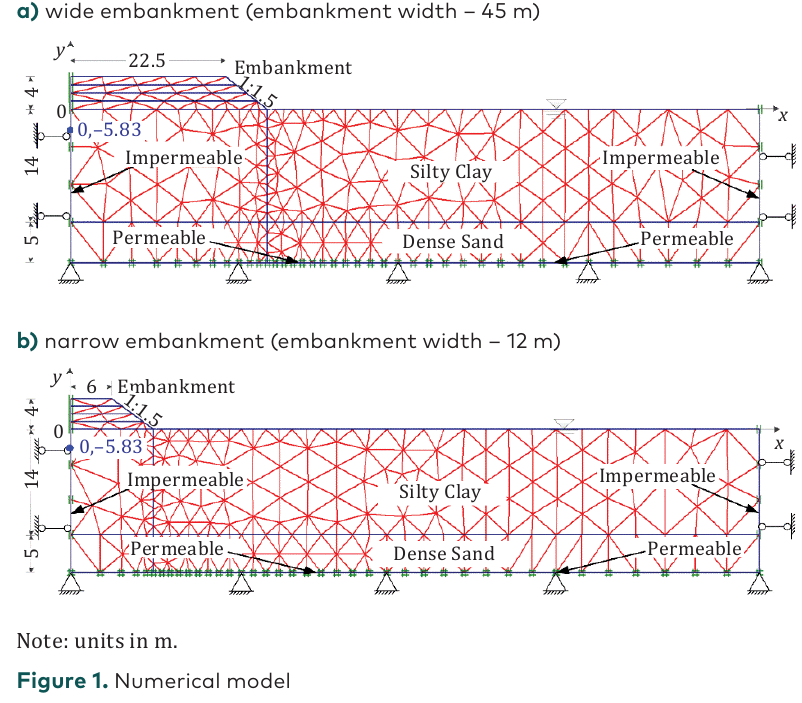
Figure 1. Numerical Note: units in m.